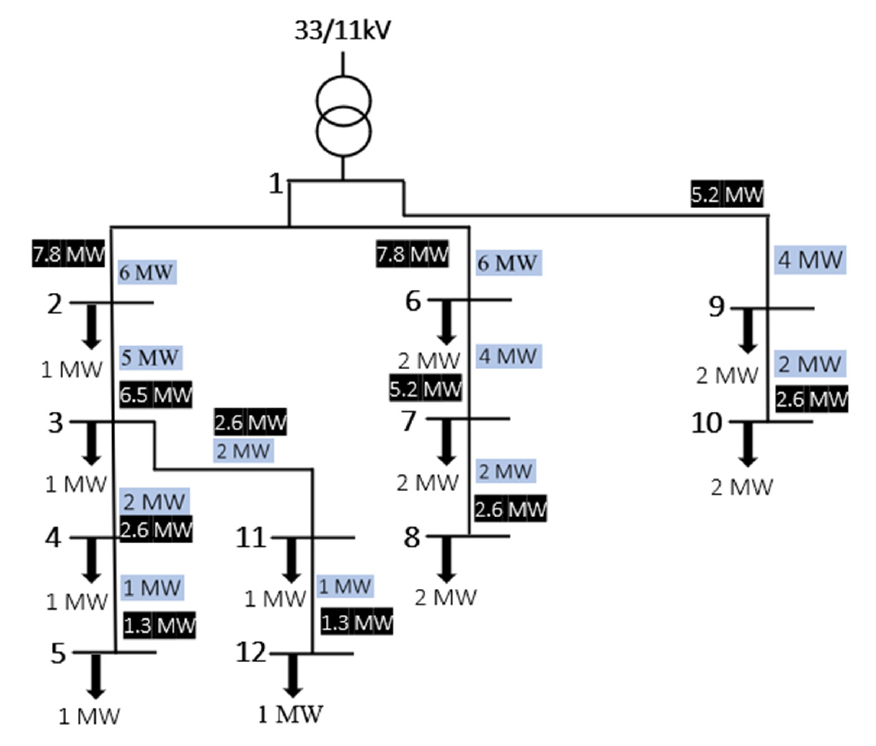
Figure 2. Schematic diagram of the HV electricity distribution network under study. All values shown correspond to the first stage of the problem; peak loads are shown under the black arrows, line thermal limits are shown in black, and the power flows are shown in blue. This schematic diagram applies to the first epoch, during the peak hourly period; it also applies to the second epoch only under scenario 3 realization (i.e., no EV integration, and baseload remains the same).